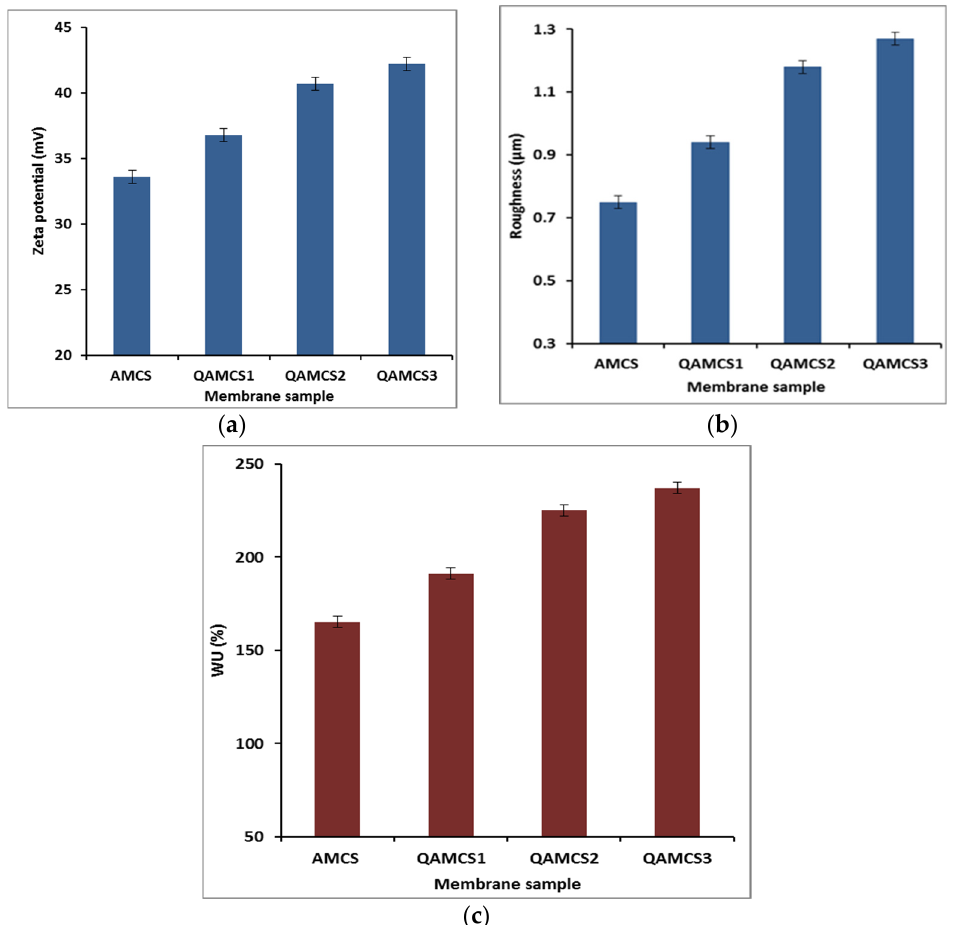
Figure 4. ( a ) Zeta potential, ( b ) roughness and ( c ) water uptake (WU%) values of aminochitosan, quaternized aminochitosan 1, quaternized aminochitosan 2 and quaternized aminochitosan 3 mem- branes. All measurements were accomplished in triplicate ( n = 3), and data obtained are expressed as means and standard deviations (±SD).